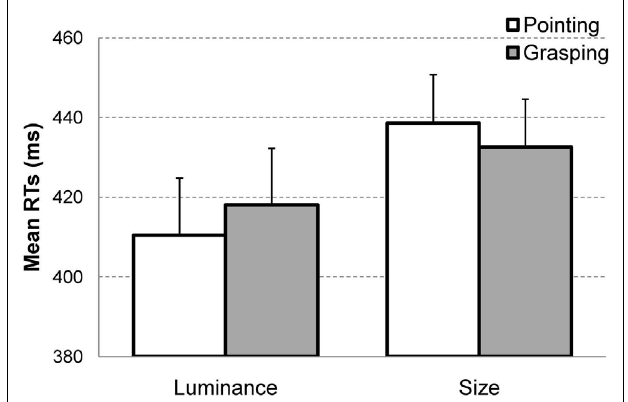
FIGURE 4 | Mean reaction times (RTs) in target present trials as a function of task type (luminance or size) and movement type (pointing or grasping). The congruency effect consists in shorter RTs for the congruent action-perception pairs, i.e., size-and-grasping and luminance-and-pointing as compared to incongruent pairs, i.e., size-and-pointing and luminance-and-grasping. Error bars represent the standard errors of the